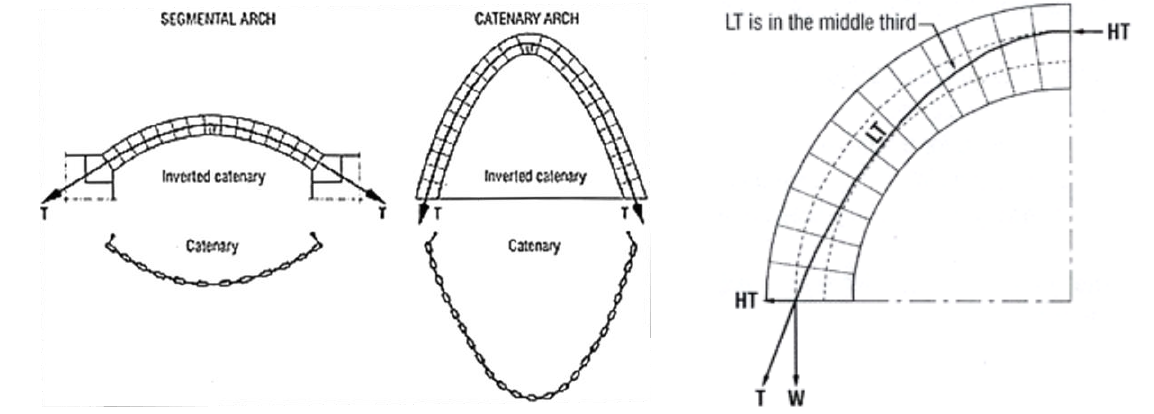
Fig. 5 catenary curves and arches (Dutton 2013). Fig. 6 forces in arches and vaults (Dutton